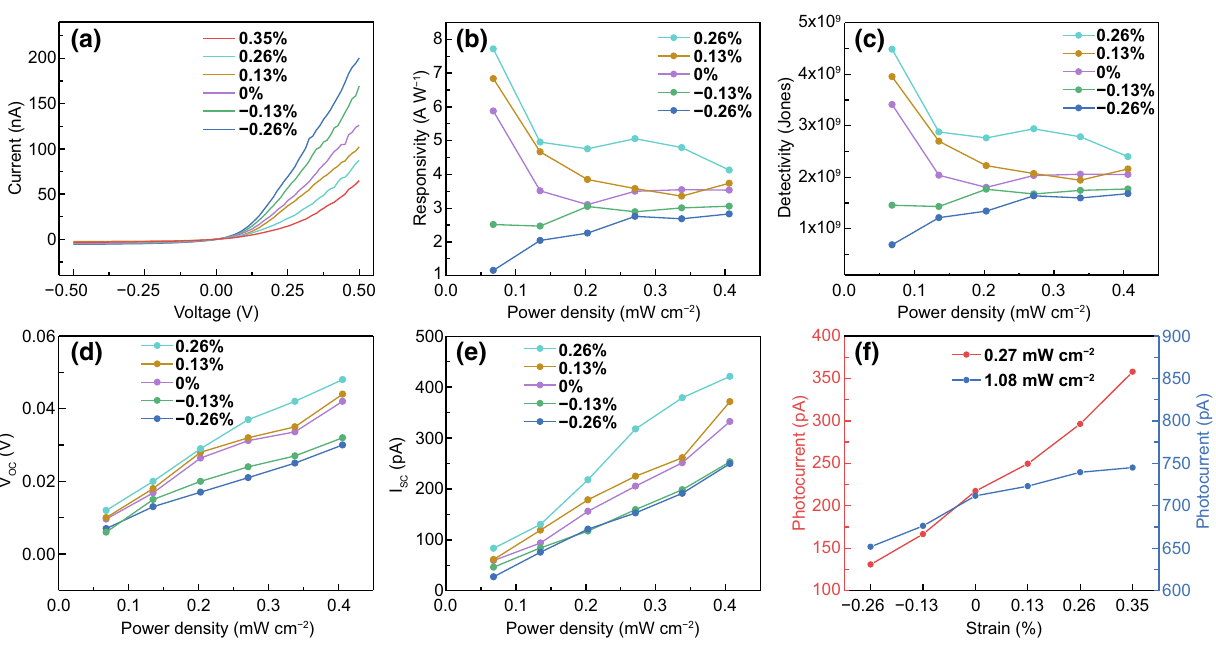
Fig. 4 The strain-modulated photoresponse to 523 nm illumination from the α-In 2 Se 3 /3R MoS 2 heterojunction. a I – V characteristic of the device under several strains in dark. b , c Responsivity and detectivity under − 0.1 V bias voltage. d , e Open circuit voltage V oc and short circuit current I s c under various light intensities and strains (The data were extracted from Fig. S7). f Average photocurrent as a function of strains under zero bias at the illumination intensities of 0.27 and 1.08 mW cm −2 (The data were extracted from Fig. S8)